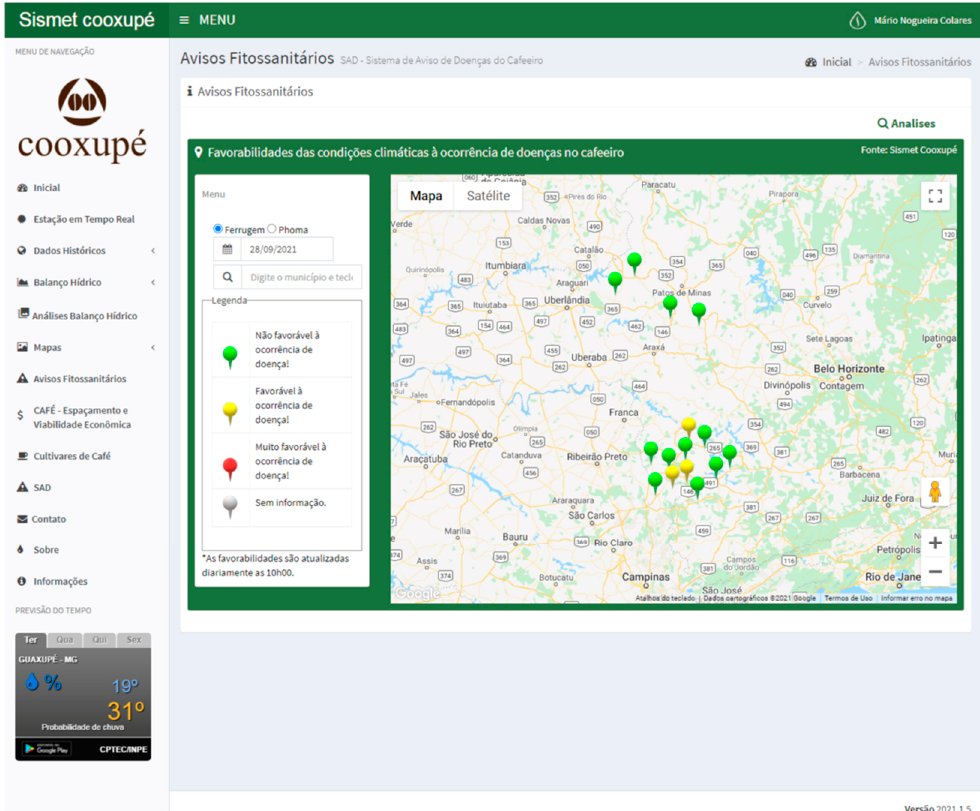
Figure 7 . Real current phytosanitary forecast system interface of the Decision Support System (DSS) project showing the favorability of climatic conditions for the occurrence of coffee leaf rust according to the icon (green: not favorable to disease occurrence, yellow: favorable to disease occurrence, red: very favorable to disease occurrence and white: no information) in 15 munici-palities in the states of Minas Gerais and São Paulo, Brazil. * Favorability are updated daily at 10 a . m.